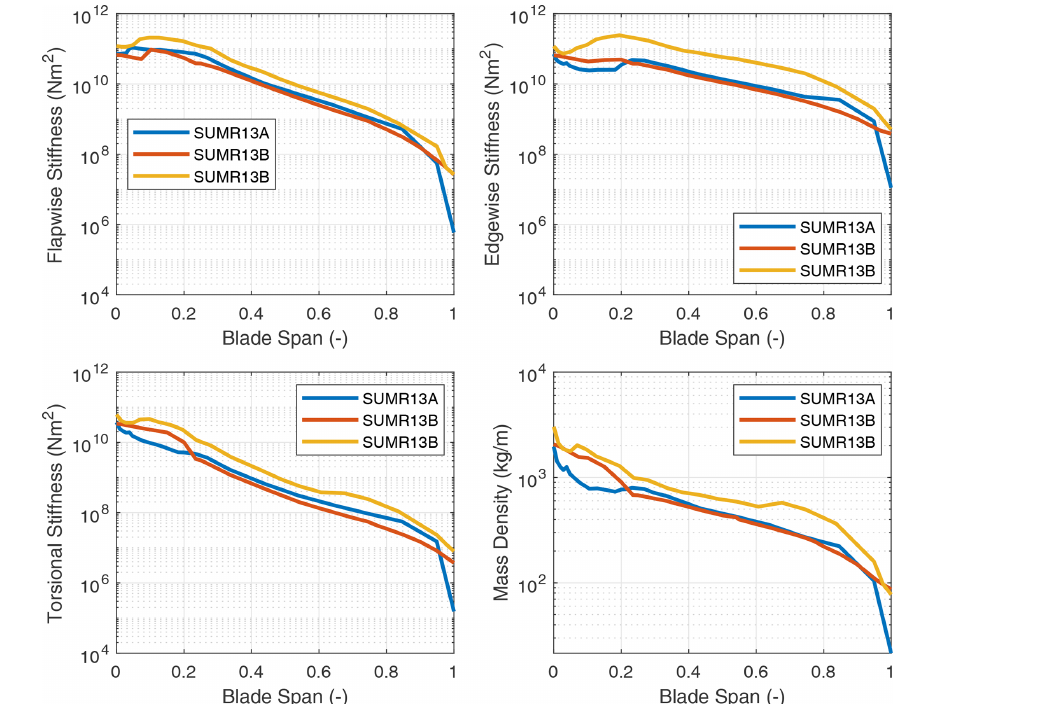
Figure 7. Flapwise stiffness, edgewise stiffness, and mass properties for the SUMR13 series of